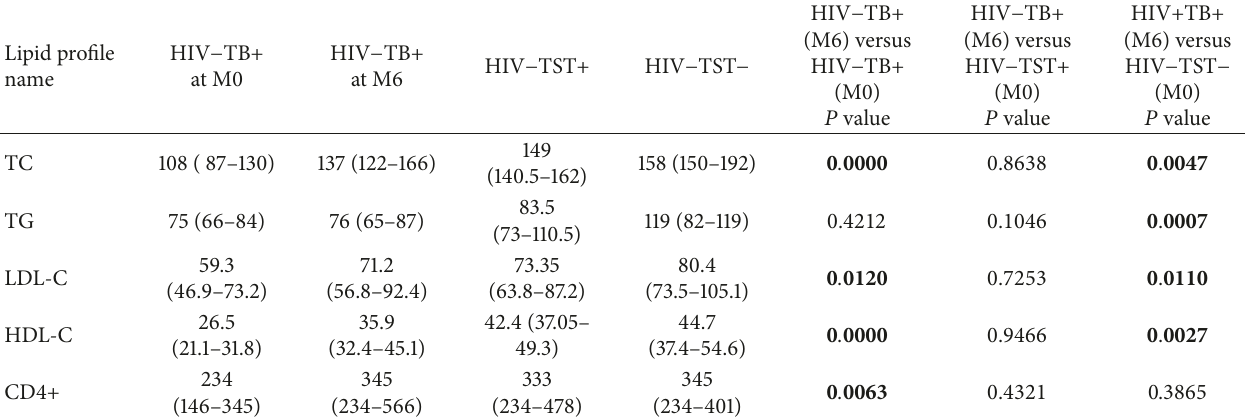
Table 4: ATT response on lipid profile concentration in HIV − TB+ patients after treatment.